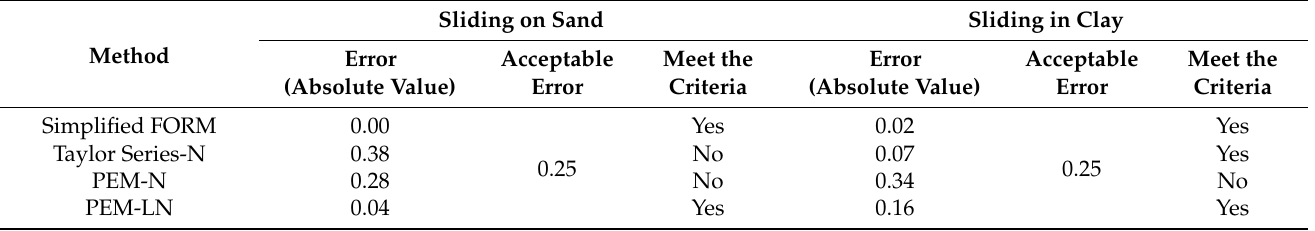
Method Taylor Series-LN